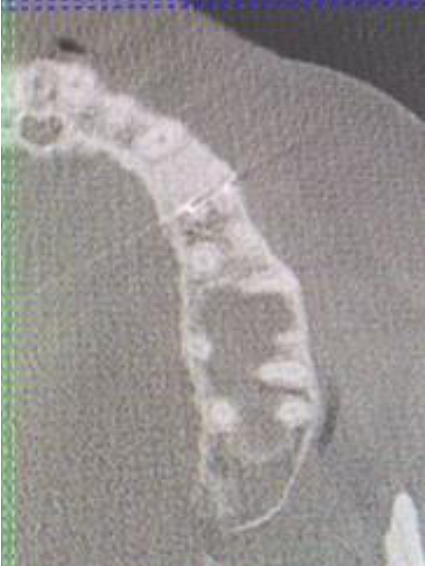
Figure 12. CBCT sagittal view after 15 months.